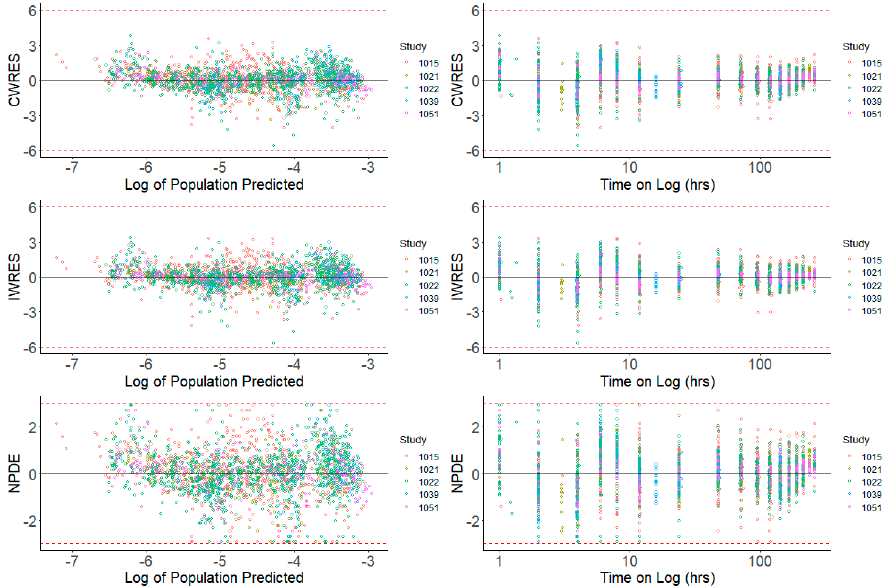
presented on the x -axis. The red dashed line represents a line of unity, and the black line represents a linear smooth line. Pharmaceutics 2020 , 12 , x